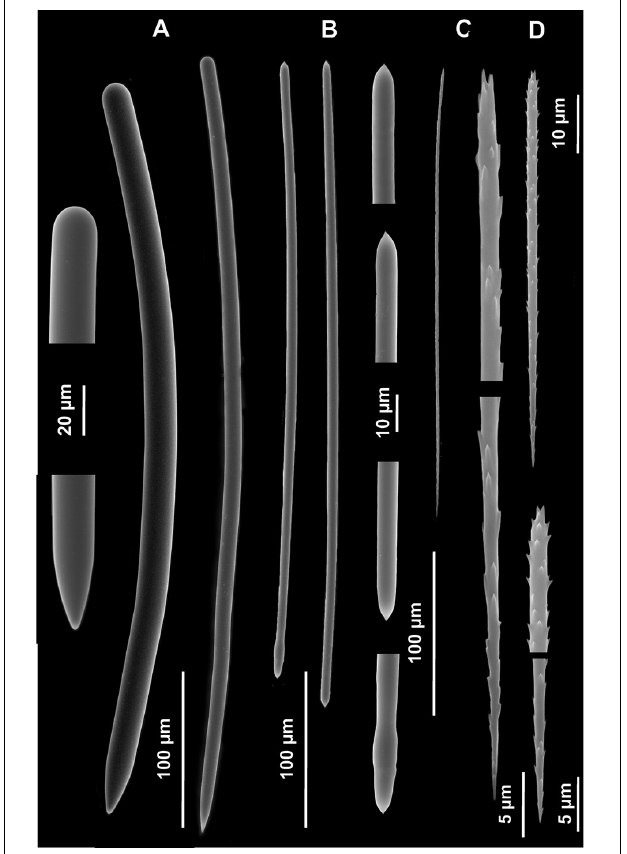
FIGURE 6 | Spicules of Tedania ( Tedaniopsis ) phacellina , Topsent, 1912. (Holotype) as seen with a Scanning Electron Microscope. (A) Styles. (B) Tornotes. (C) Onychaetes I. (D) Onychaetes